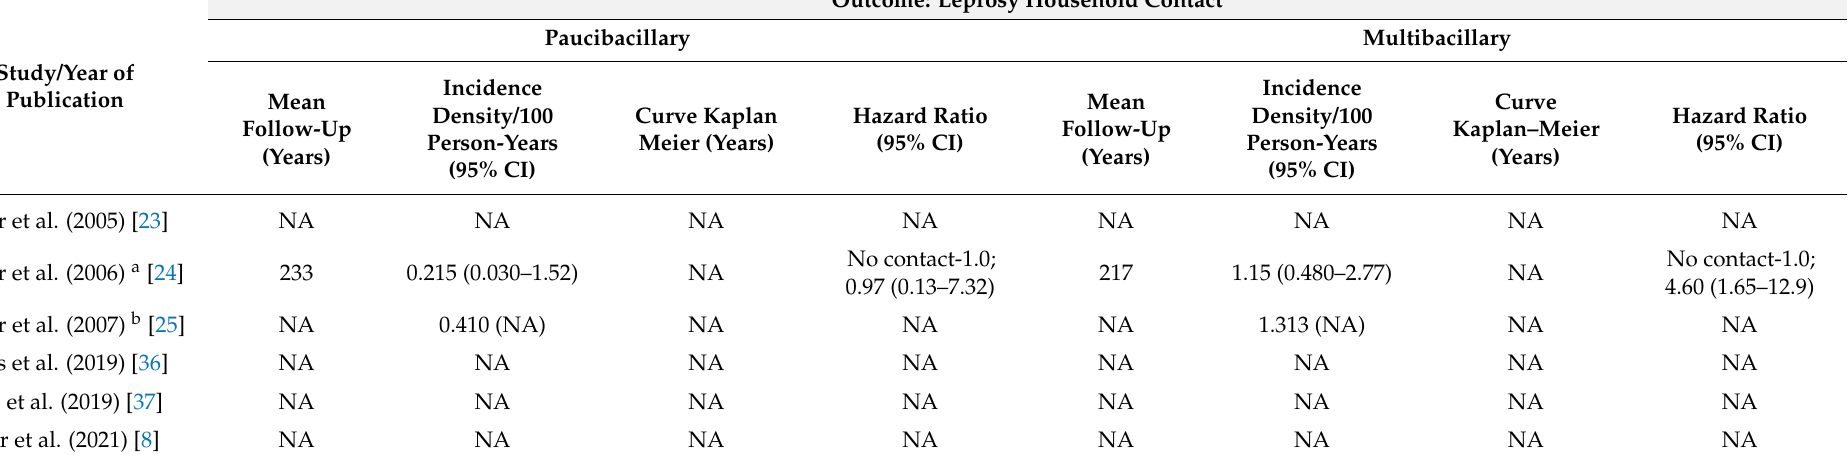
Table 2. Reporting survival analyses of the included studies by outcome leprosy household